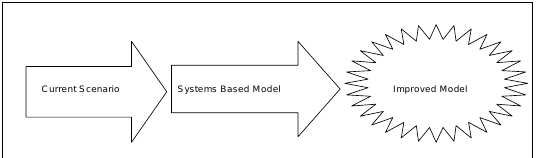
Figure 7: The role of the systems based